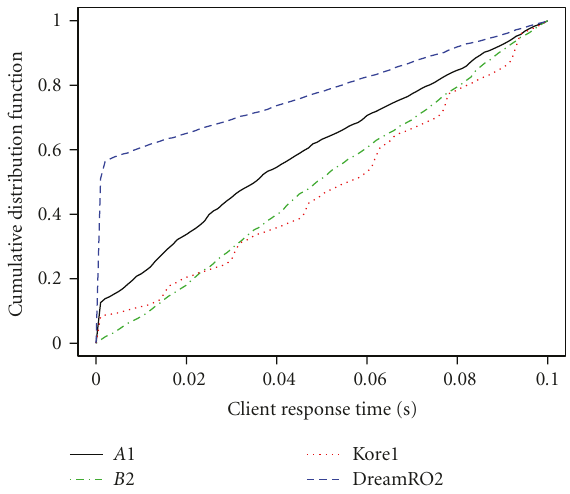
Figure 6: CDF of client response